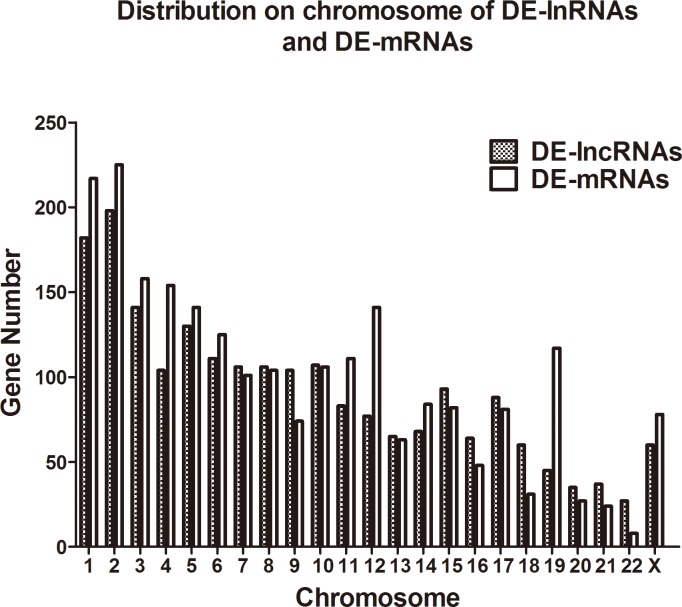
Distribution of differentially expressed lncRNAs and mRNAs on chromosomess.